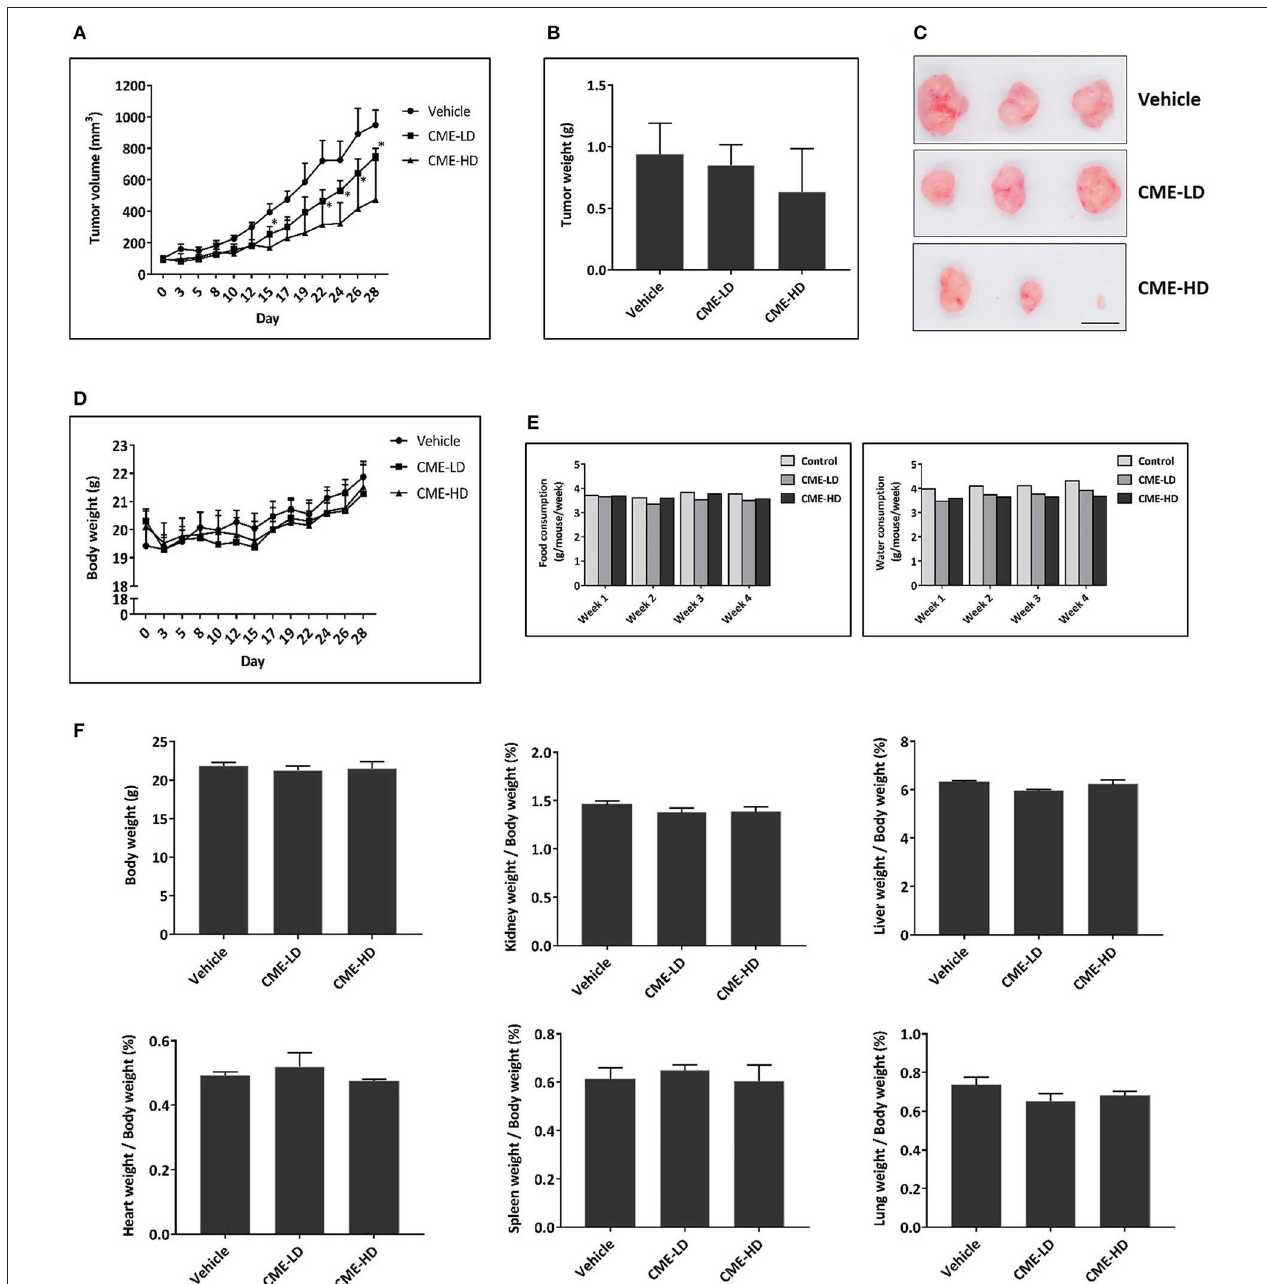
FIGURE 7 | CME inhibited the growth of TNBC in vivo . A xenograft breast cancer model was established by subcutaneous injection of MDA-MB-231 cells into BALB/c nude mice. Upon development of tumors to a palpable size, mice were randomized into different groups and received daily treatment with vehicle (0.5% CMC), CME-LD (25 mg/kg), or CME-HD (50 mg/kg) via oral gavage. The experimental period lasted for 28-days, after which mice were sacrificed, and their tumors and organs excised for further analysis. (A) Longitudinal assessment of tumor volume. (B) Tumor weight at experimental endpoint. (C) Representative photographs of tumors at experimental endpoint. Scale bar, 10mm. (D) Mouse body weight, and (E) food and water consumption throughout the 28-days experimental period. (F) Mean organ weights normalized to body weights. Error bars represent means ± SEM. * P < 0.05 compared to control.